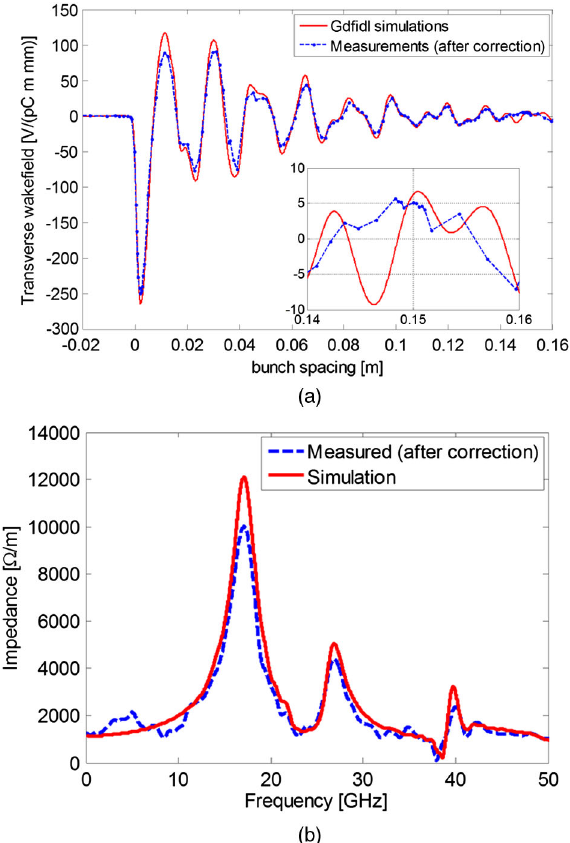
FIG. 10. (a) Wakefield plots after artificially correction on the timing shift. (b) Spectrum of measured data after timing correction.